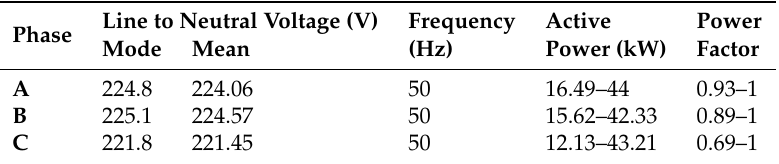
Table 12. Grid parameters: